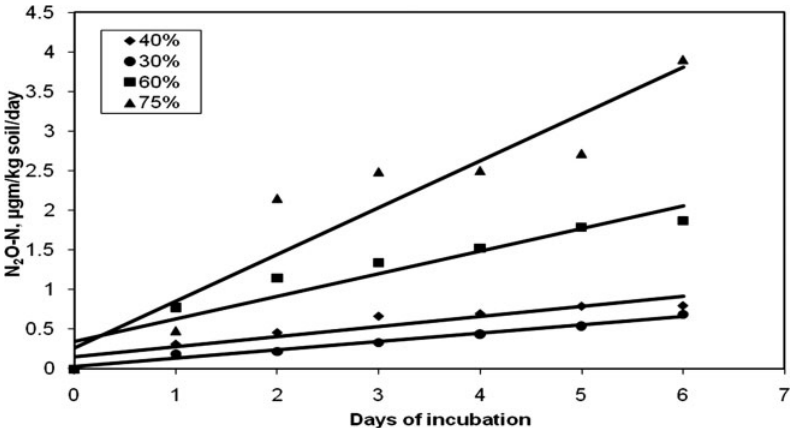
Fig. 2. Nitrification and denitrification rate of Sorada soil (Conditions: Temperature (cid:3) 37 8 C, WFPS (cid:3) 30%, 40%, 60% and 75%)